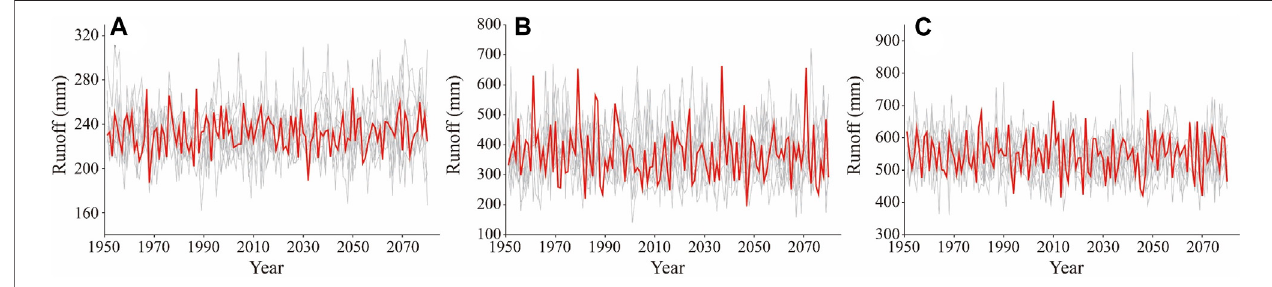
FIGURE6| Thesimulatedannual runoff series (gray lines)ofthe nineGCMs and thesimulation-based median runoff series (redline) during 1951 – 2090for allthree source areas of the South-to-North Water Diversion project ( (A – C) denote source areas of the western route, the middle route, and the eastern route, respectively).